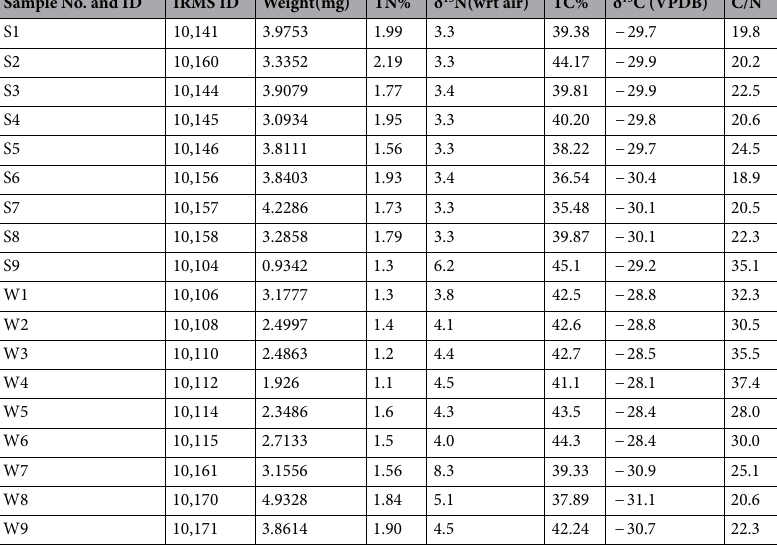
Table 1. List of the stable δ 13 C and δ 15 N isotope data in Red Panda feces sample collected from summer and winter season. S1–S9 summer sample; W1–W9 winter